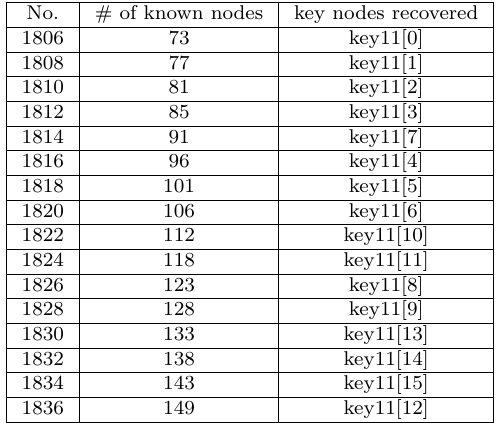
Table 10: Attack on AES found by TADA - Each row corresponds to a vulnerable instruction with sequence number “No.” such that after the attack on this instruction, the number of known nodes is given by “# of known nodes” and the key nodes that are retrieved are given by the third